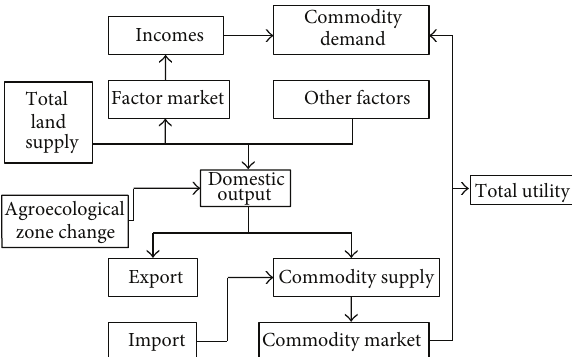
Figure 2: Overview flow chart of economic module applying a CGE modeling